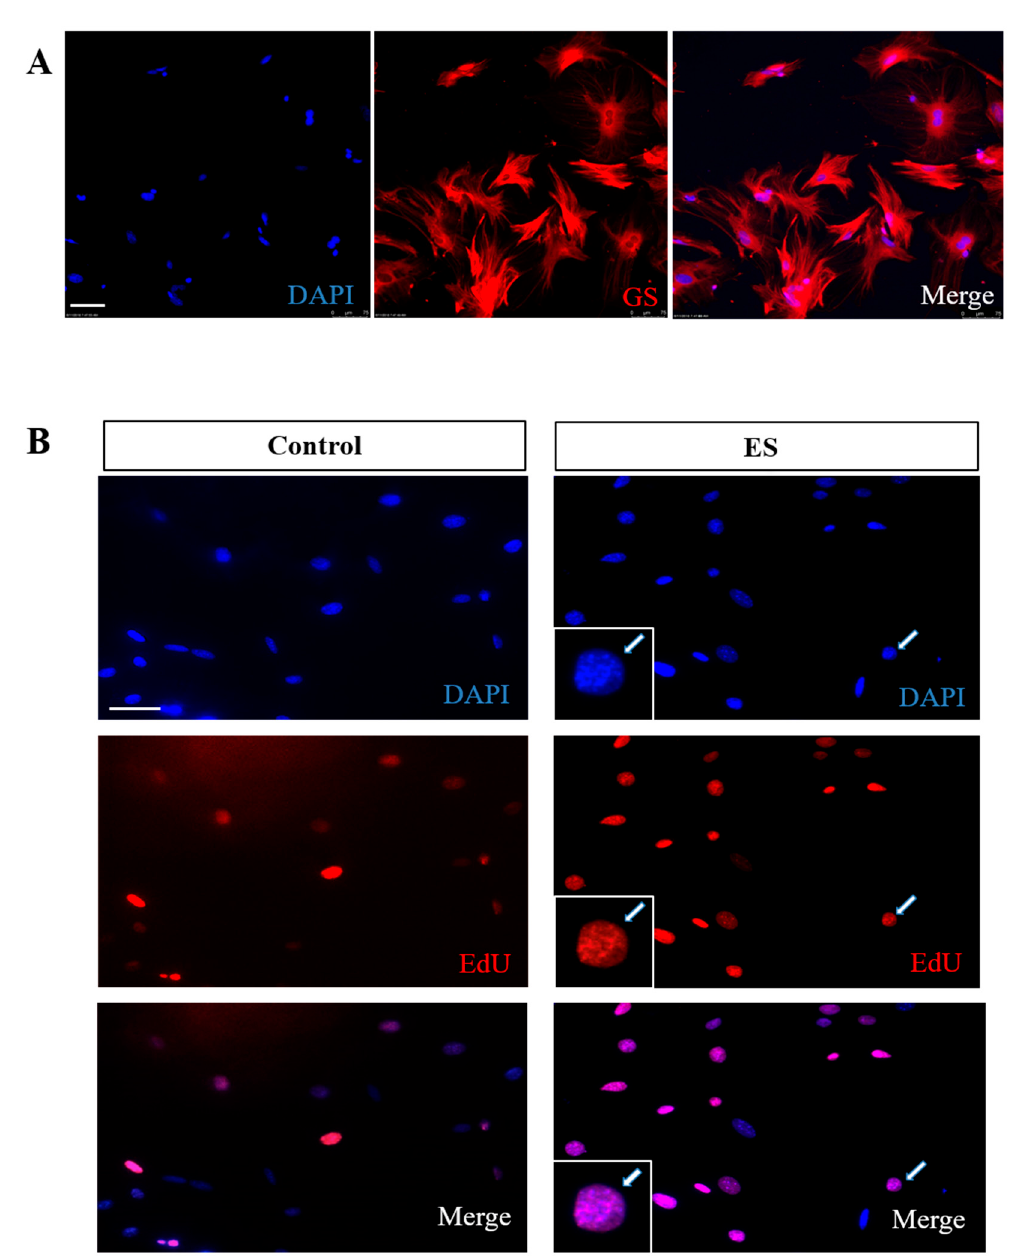
Figure 1. The e ff ect of electrical stimulation (ES) on cultured Müller cells (MCs). ( A ) Photomicrographs showing isolated MC cultures immunolabeled for MC specific marker glutamine synthetase (GS; red) and counter-stained with a nuclear marker 4 (cid:48) ,6-diamidino-2-phenylindole (DAPI) (blue). Note that most cells in isolated MC cultures expressed typical MC marker GS. ( B ) MC proliferation assessed by EdU incorporation. MCs were stimulated with ES or sham-treatment (control) for 1 h. Note the increased number of EdU + (red) cells 2 days after ES treatment as compared to the control group. Scale bar = 20 µ